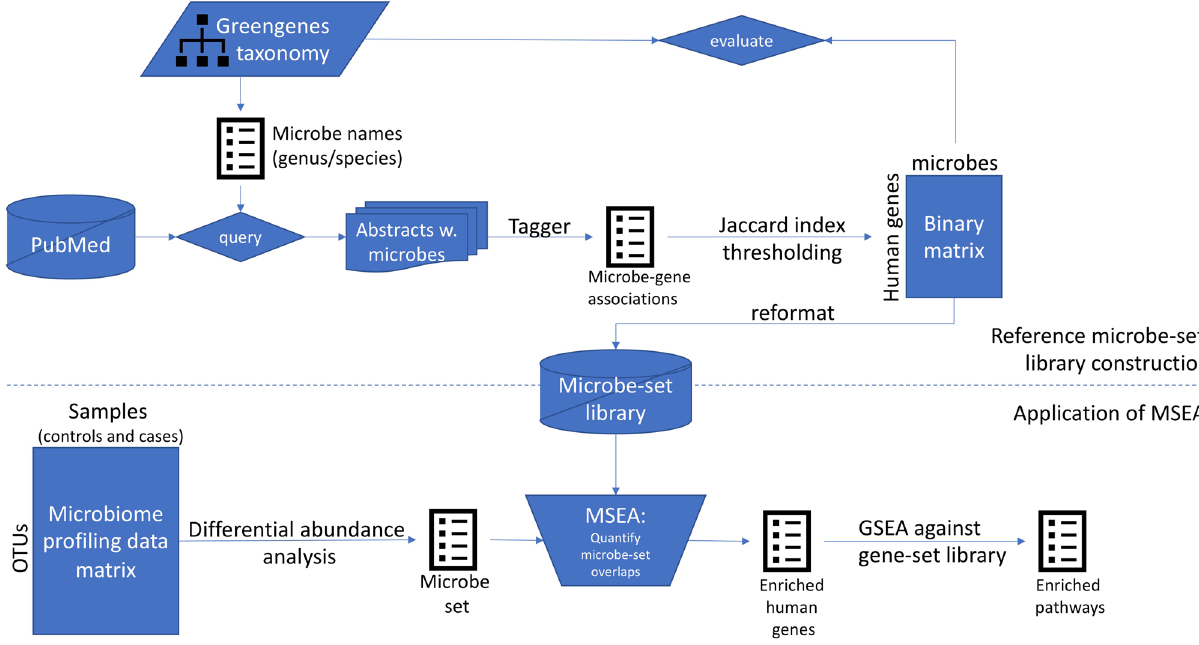
Figure 1. Chart showing the workflow of the construction of microbe-set library and application of